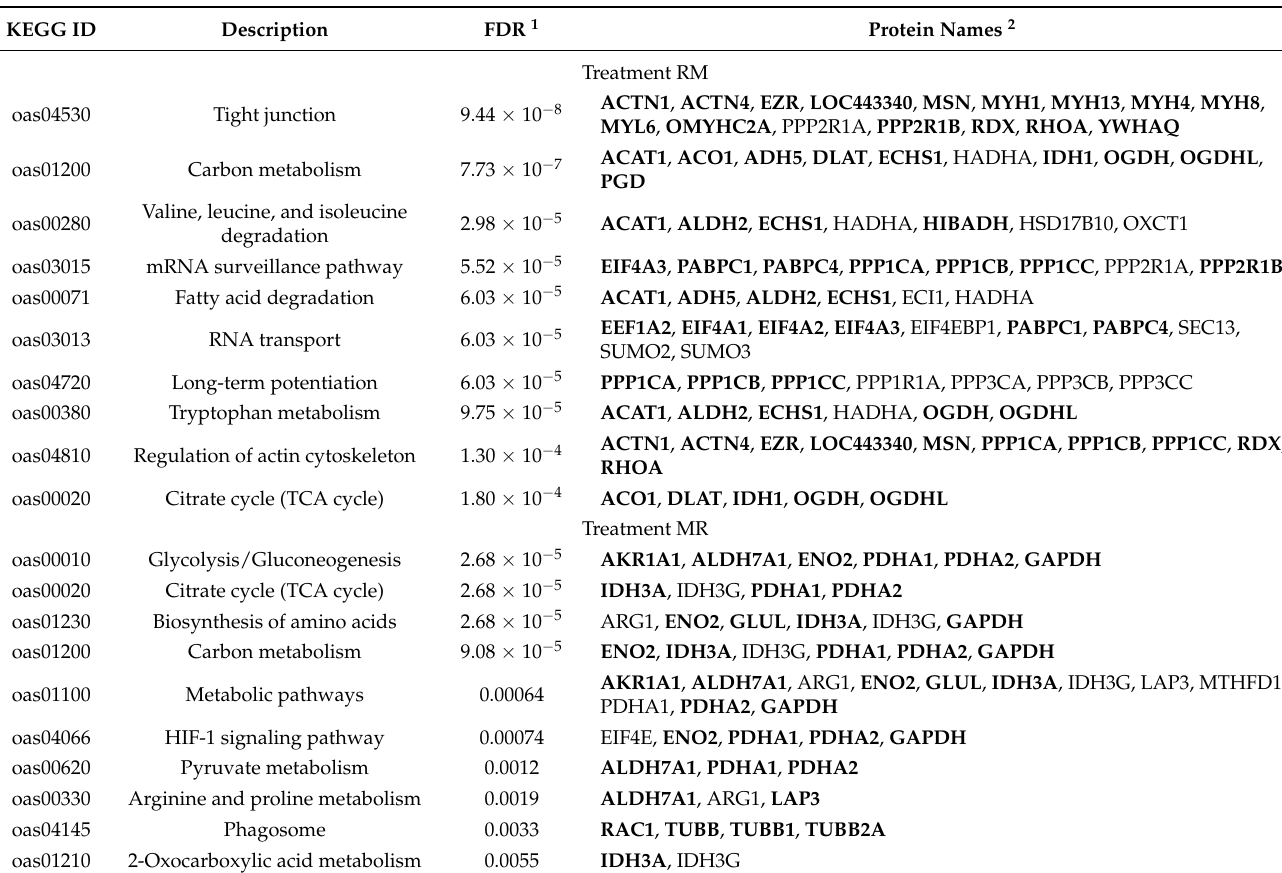
Table 2. Enriched metabolic pathways of the exclusive proteins from treatment RM and